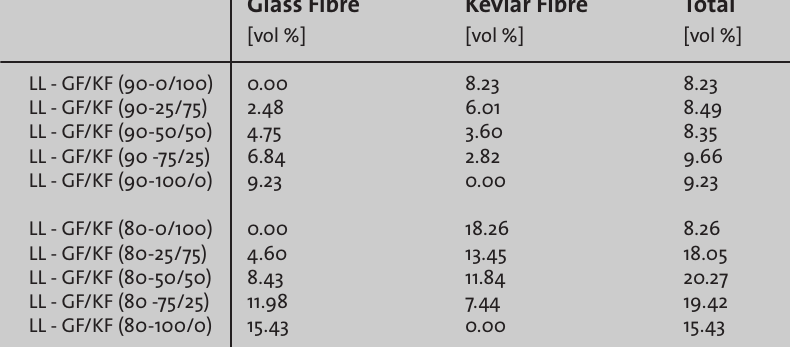
percentage of fibres in LLDPE